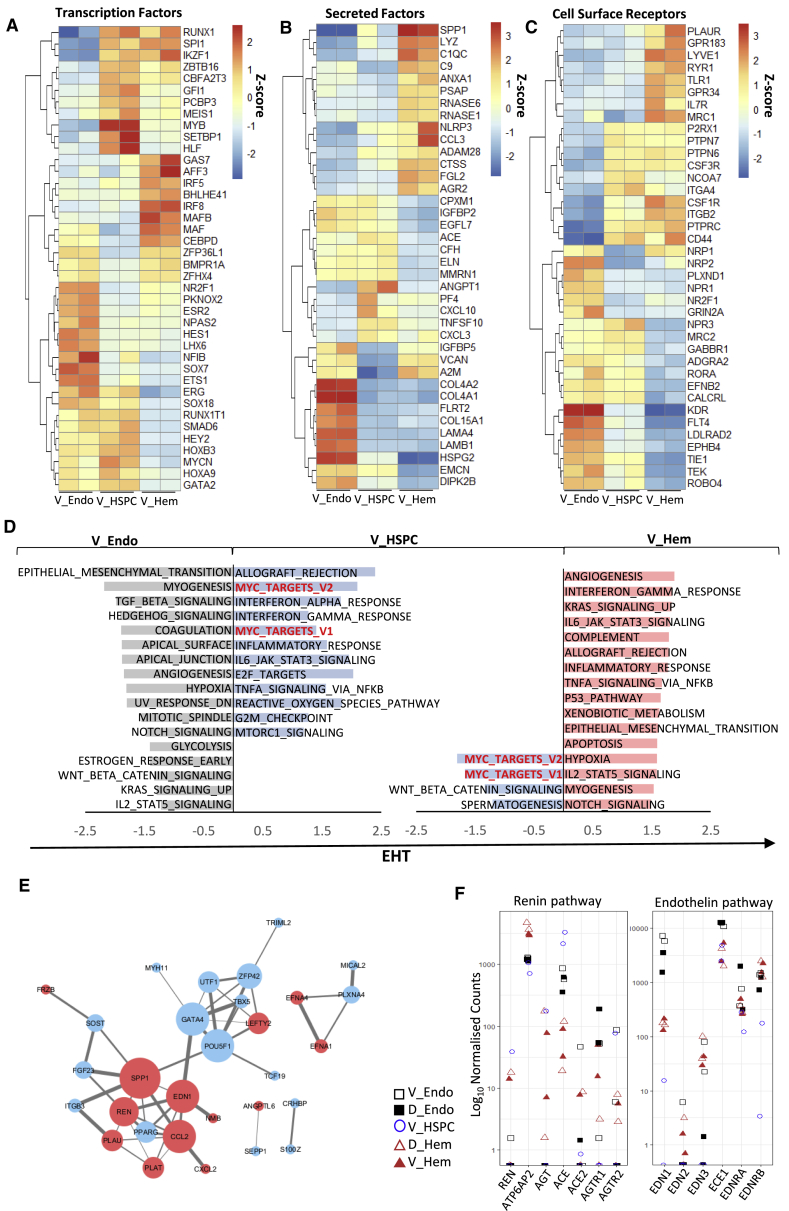
Dynamics in Gene Expression across the Endothelial-to-Hematopoietic Transition (EHT)(A–C) Heatmaps of relative expression levels for TFs (A), secreted factors (B), and receptors (C) that are differentially expressed in V_Endo versus V_HSPC and in V_HSPC versus V_Hem (p.adj < 0.05).(D) Patterns of signaling along EHT. Shown is GSEA pathway enrichment for V_Endo versus V_HSPC populations and V_HSPC versus V_Hem populations. Overlapping pathways enriched in V_HSPC in both comparisons are shown in red text (FDR < 0.25).(E) StringDB interactions between LCM-seq1 V_Inner (versus D_Inner) and V_Mid (versus D_Mid) secreted factors (red) and V_Endo (versus D_Endo) genes (blue). The size of a node indicates the number of connecting edges. The width of a line indicates confidence of the interaction; confidence levels = 0.4–0.9).(F) Dot plots of normalized expression levels of endothelin and renin core pathway genes for hematoendothelial populations.